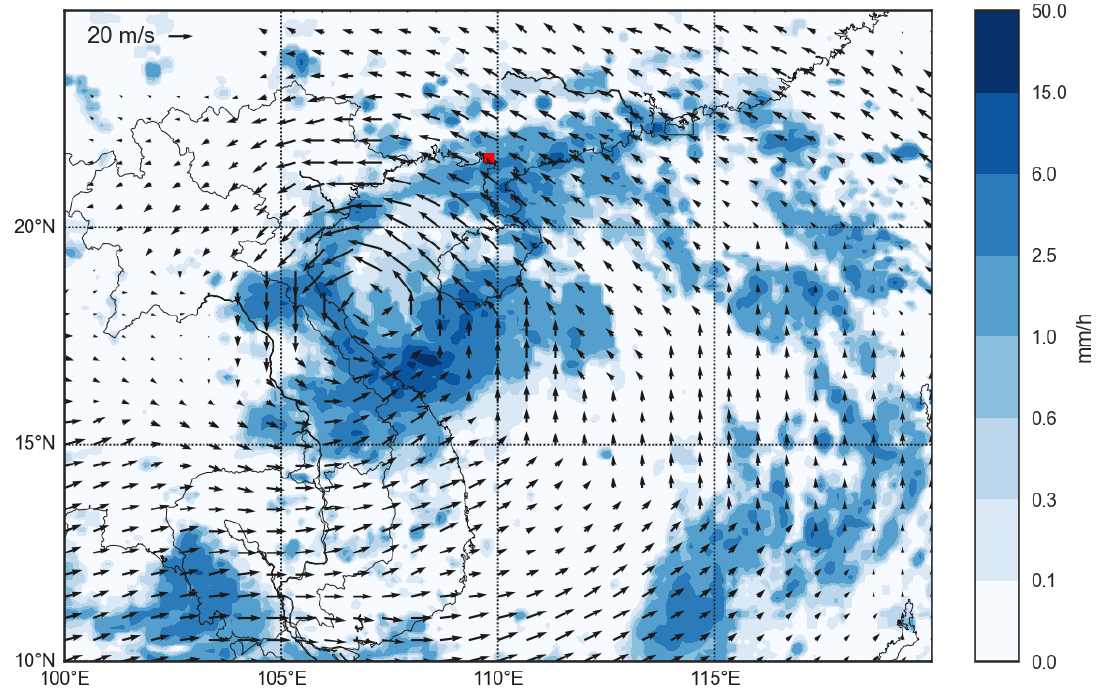
Figure 13. Spatial distributions of precipitation based on GPM observations and lower tropospheric (850hPa) horizontal winds based on the MERRA-2 reanalysis on 16 July